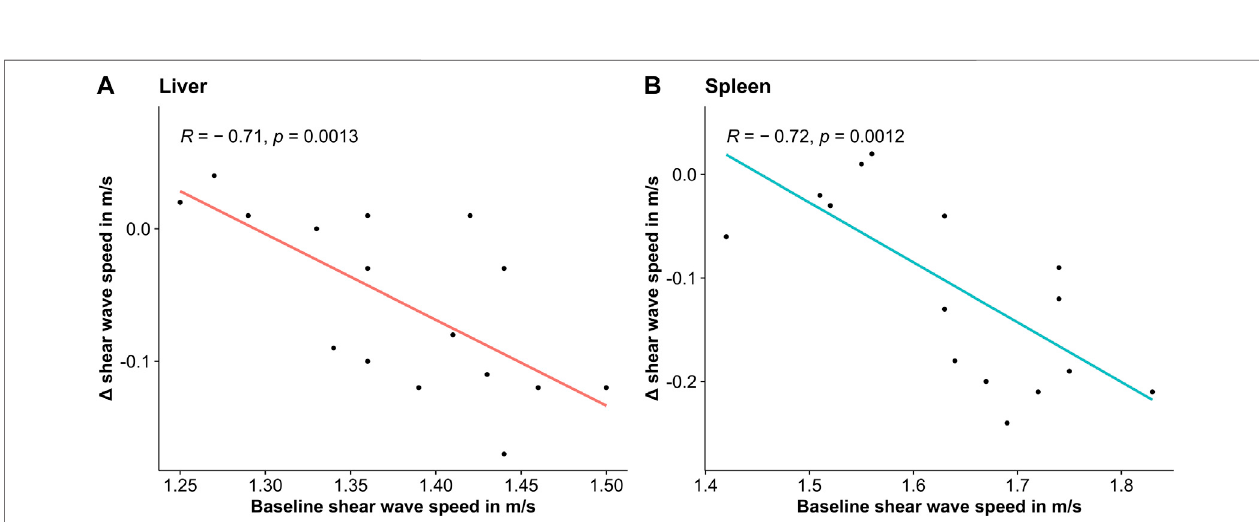
Frontiers in Bioengineering and Biotechnology |